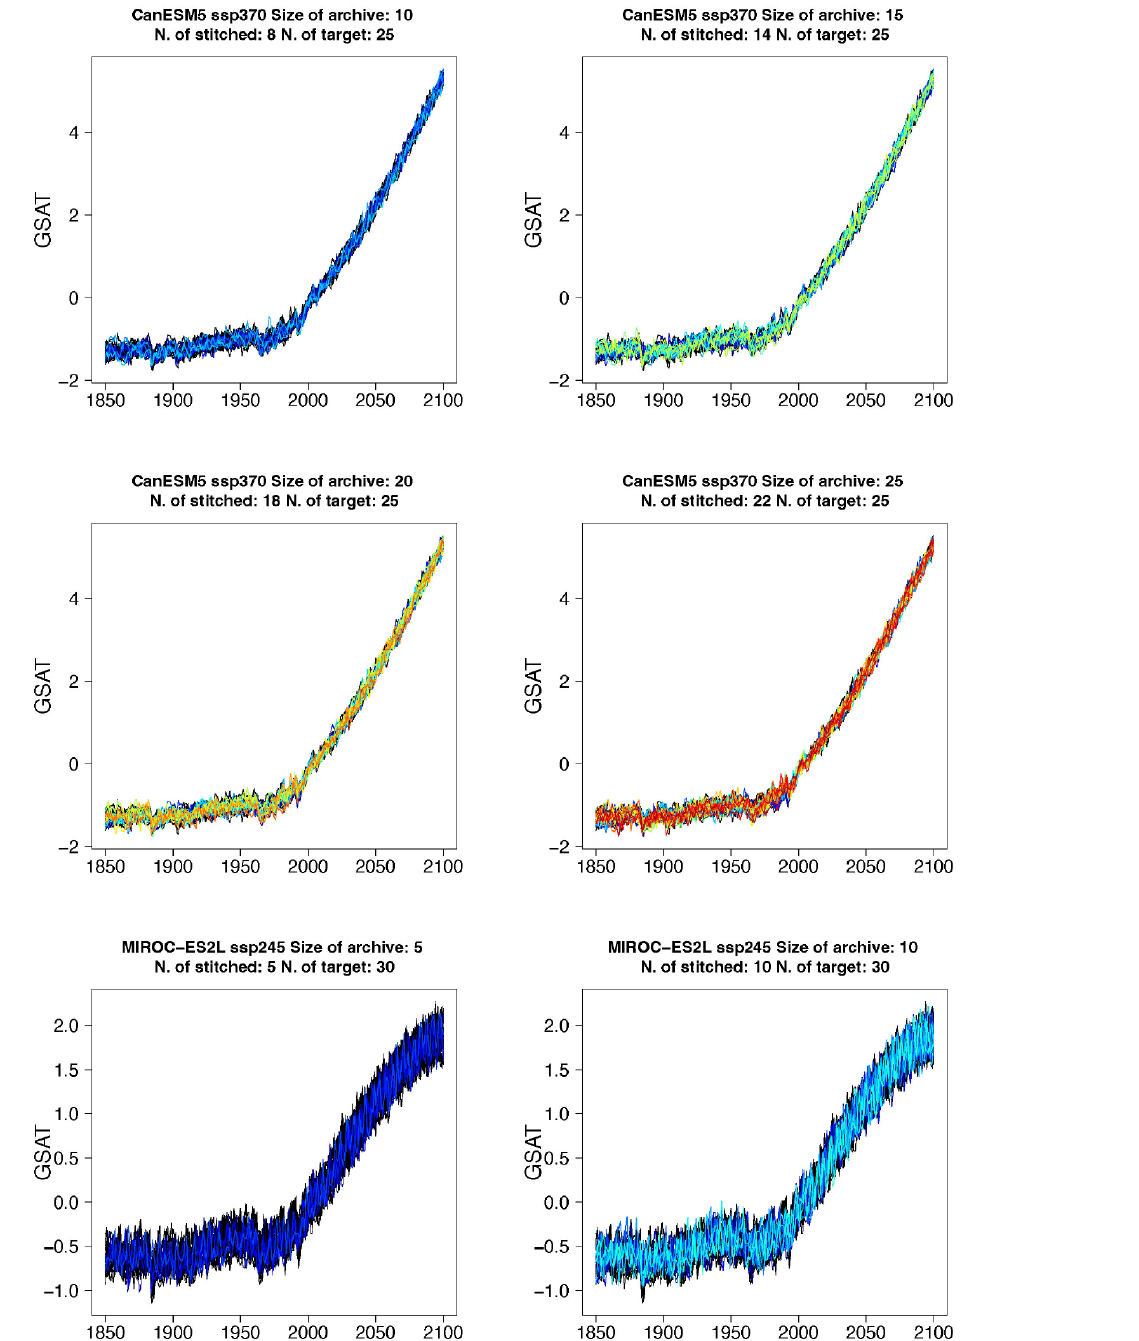
Figure E3. Examples of enriched ensembles of GSAT time series for ESMs in the PANGEO archive that have at least five trajectories available over the 21st century. As in the figures in Appendix A, warmer colors indicate a larger number of stitched trajectories in the figure, as the title also